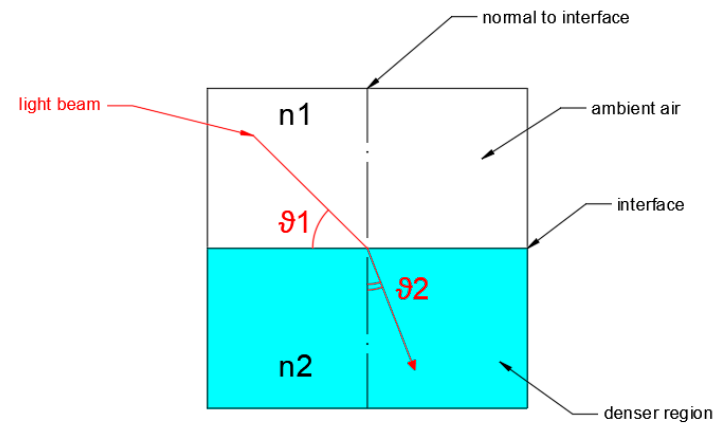
Figure 10. Snell law.